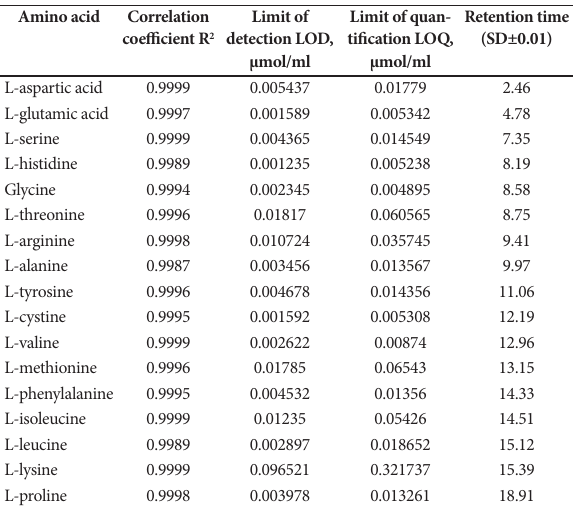
Table 2. Performance parameters of the amino acid determi- nation method. Amino